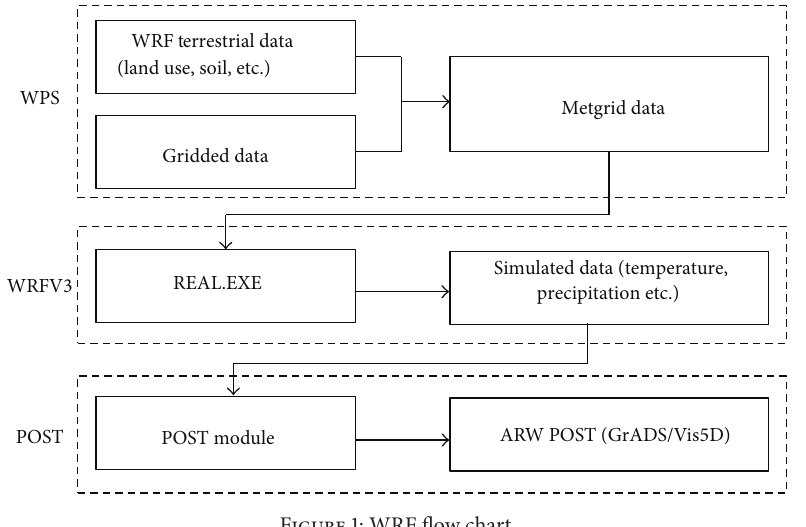
Figure 1: WRF flow